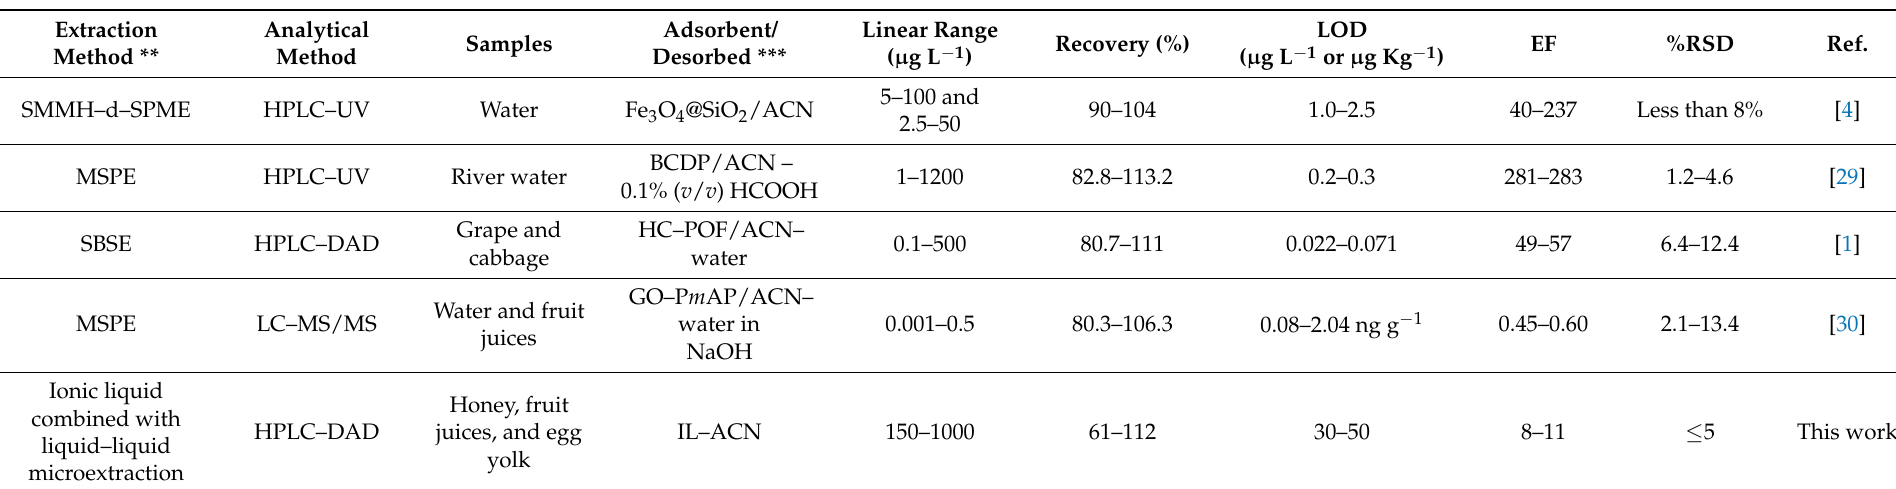
Table 3. Comparisons of the proposed method with other methods for the quantitation of triazole